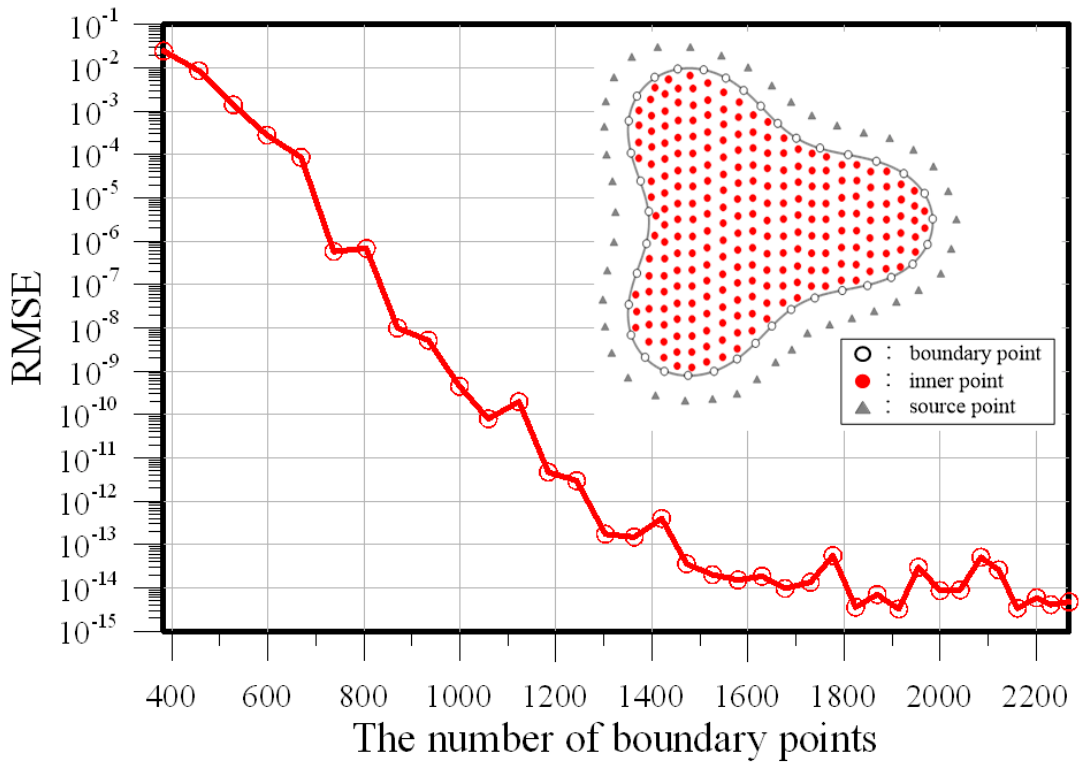
Figure 10. Number of boundary points versus RMSE.